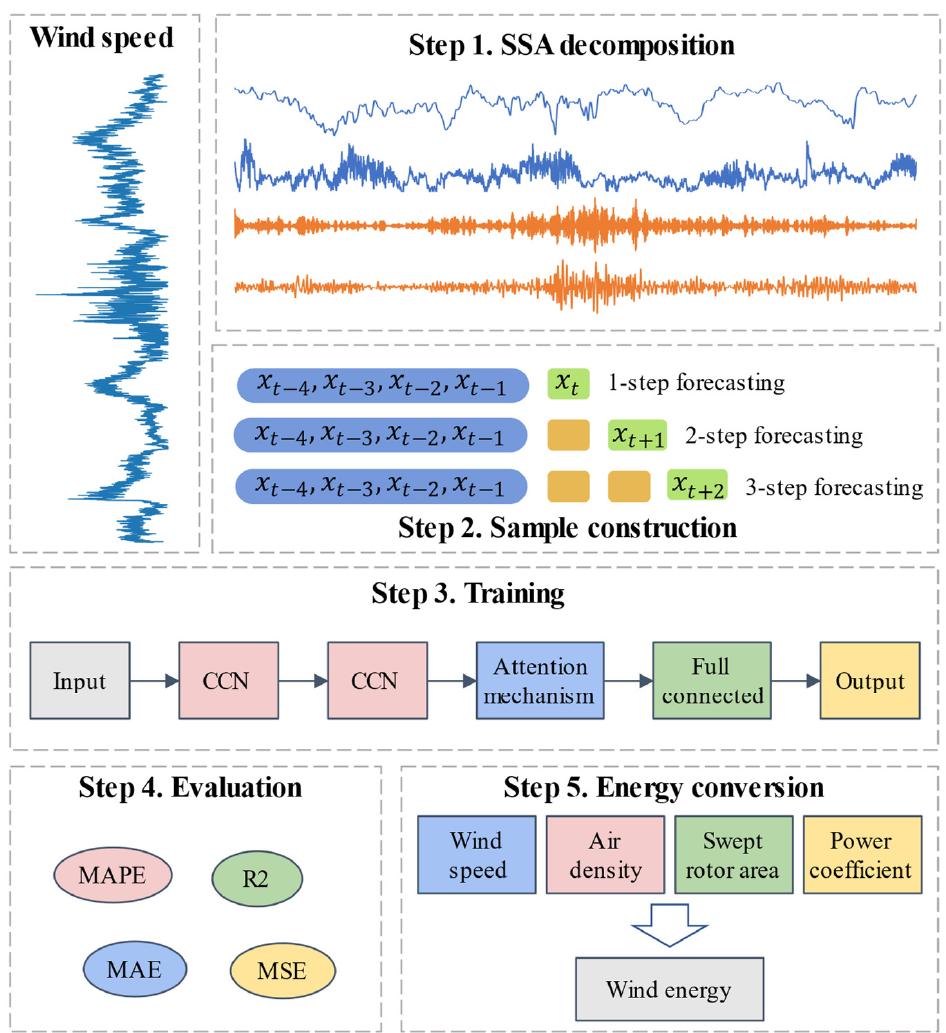
Figure 2. The flowchart of the proposed SSA-CCN-ATT model.